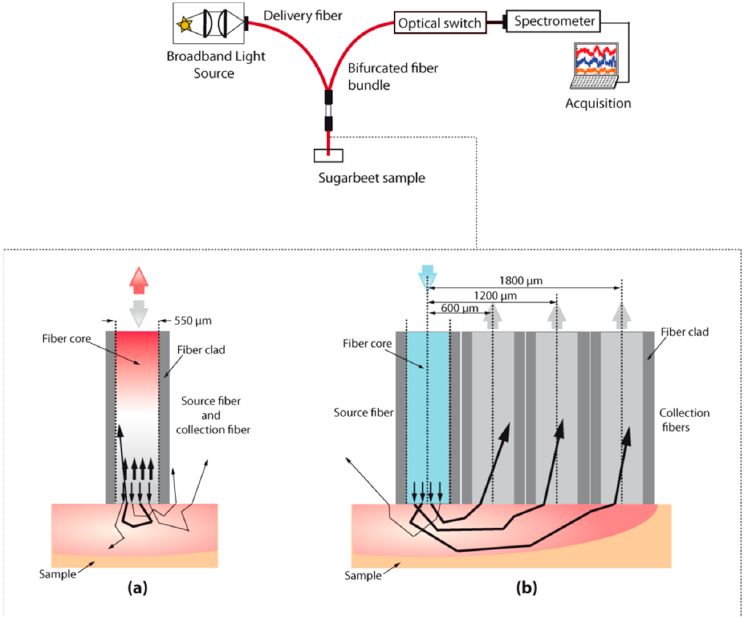
Figure 2. ( a ) Schematic diagram of the single ‐ fiber probe. ( b ) Schematic diagram of the multiple ‐ fiber probes.